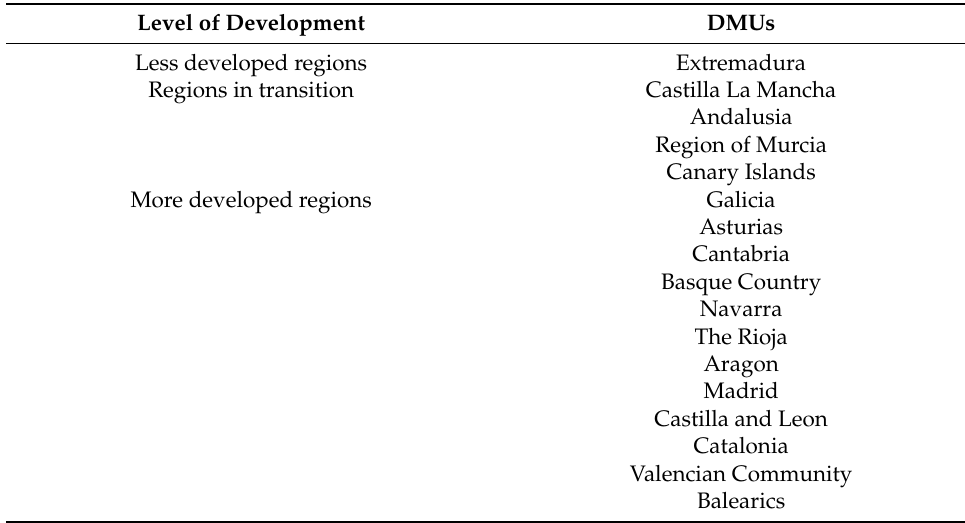
Table 4. DMUs used and level of